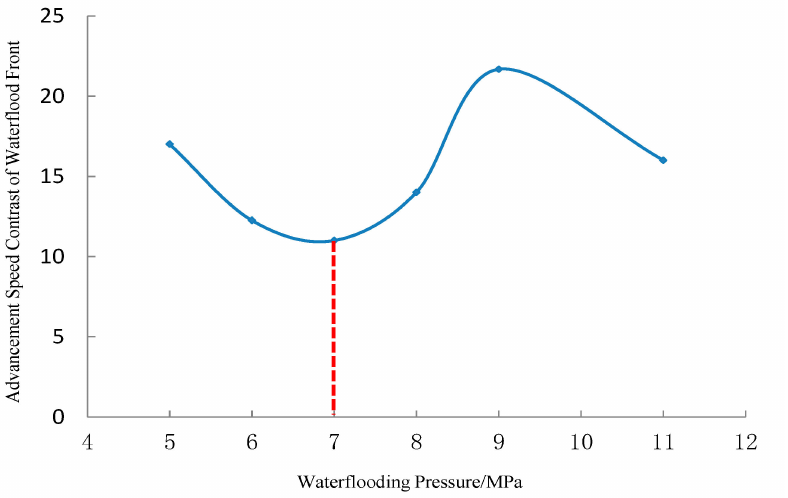
Figure 16. Relation curve of waterflooding pressure and advancement speed contrast of the water- flood front. Red dotted line means the value of waterflooding pressure is